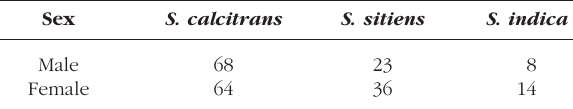
Sex S. calcitrans S. sitiens